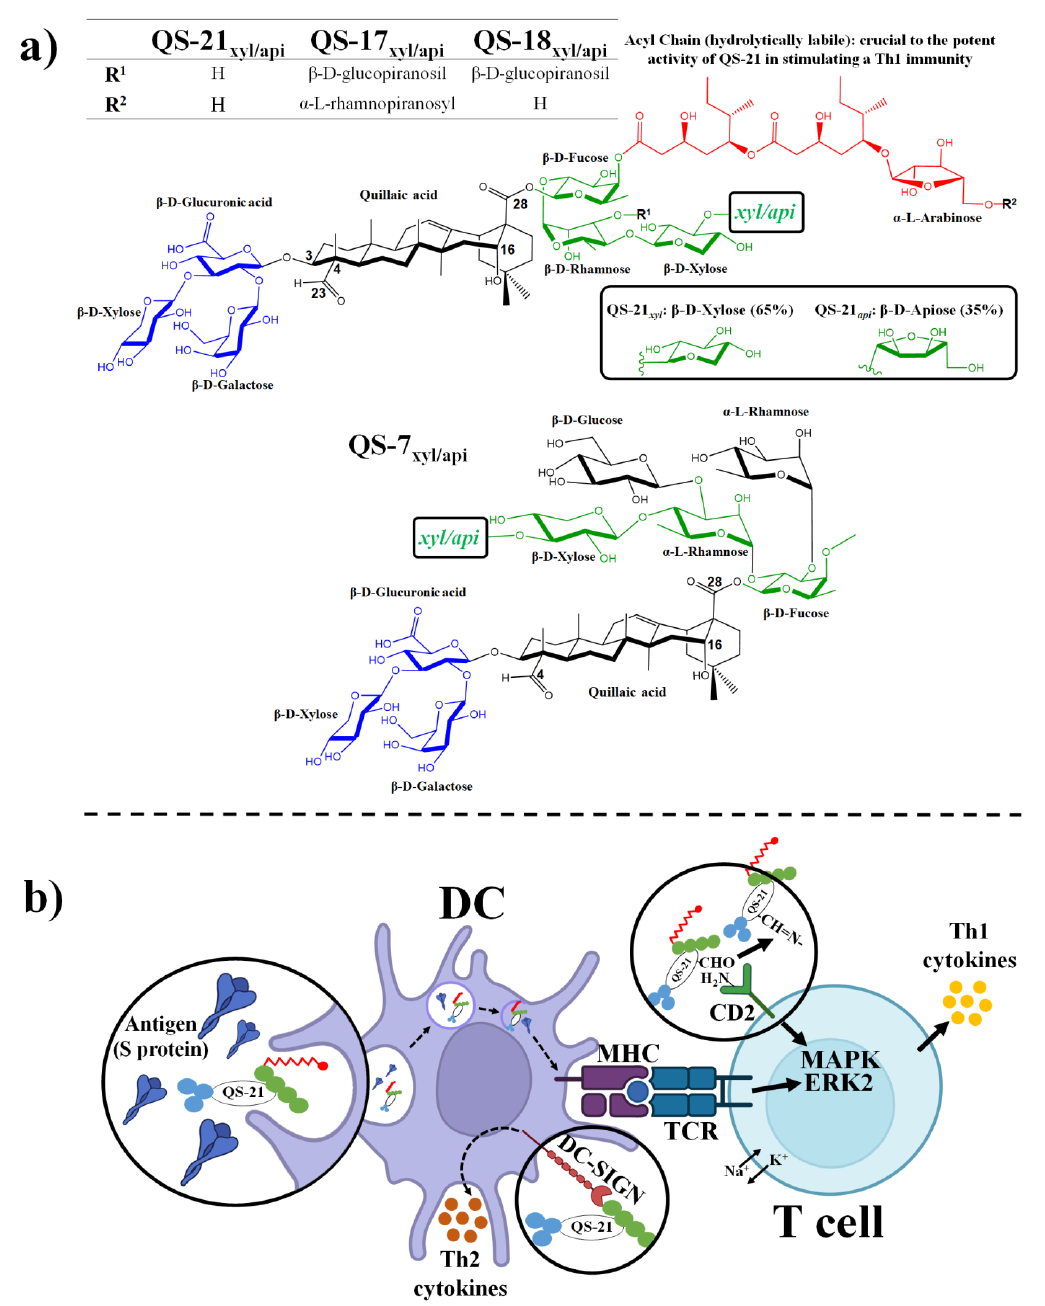
Figure 6. Structure-activity relationship of saponins from Quillaja saponaria and adjuvant mechanism of action of QS-21. According to Wang et al. [121] and Marciani et al. [123], QS-21 is